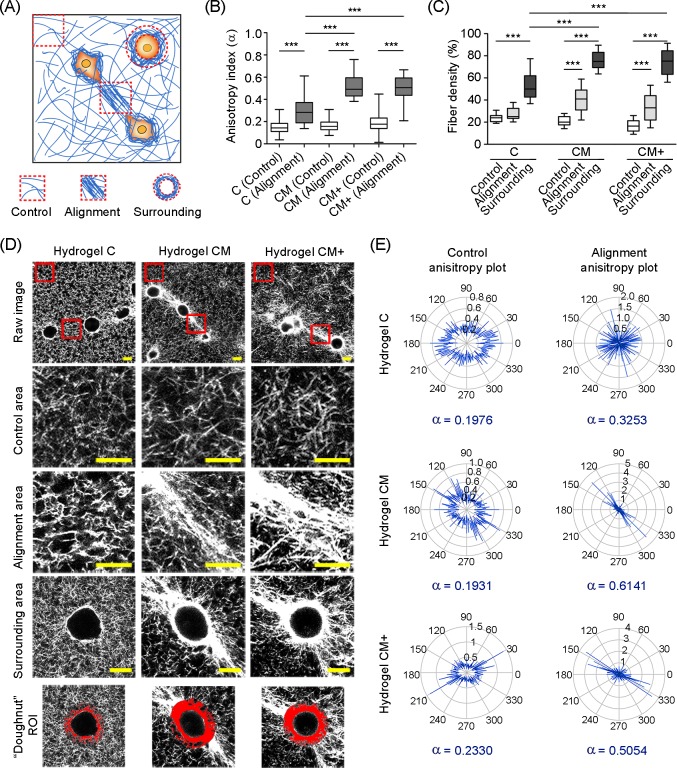
Quantification of hydrogel remodeling.(A) Schematic diagram showing cells (orange), collagen fibers (blue), and the location of theControl, Alignment and Surrounding areas used in the quantification. (B) Control and alignment anisotropy (α) measured in each hydrogel type. (Number of images, n = 21). (C) Densification results in control, alignment and surrounding areas of cells. (Number of images, n = 21). *** Indicates highly statistically significant difference between groups (p<0.001). (D) Representative images of hydrogels C, CM, and CM+. Scale bar = 10 microns. (E) Polar plots and anisotropy coefficients of the representative images shown in D.